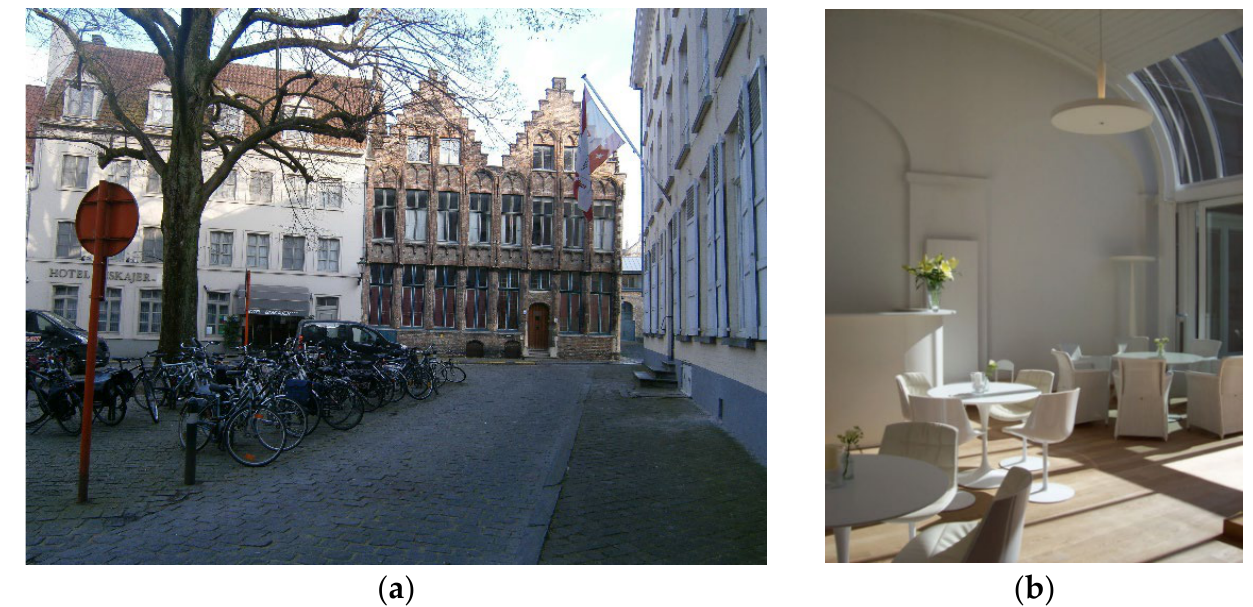
Figure 15. Selection of main pictures of the Fotonhouse in Bruges. Source: ( a ) Foton, ( b ) Own elaboration, 2020. ( a ) The Fotonhouse is in the city center of Bruges, integrated in the urban tissue and with connectivity to open public spaces in a quiet and calm environment. ( b ) The Kopje Troost room in the Fotonhouse has offered a quiet place since 2005 for social meetings and both formal and informal meetings between people with dementia, families, and caregivers. They offer a community library with different audio-visual material, cultural and musical activities, memory choirs that are run by volunteers, and many other celebrations over the year.